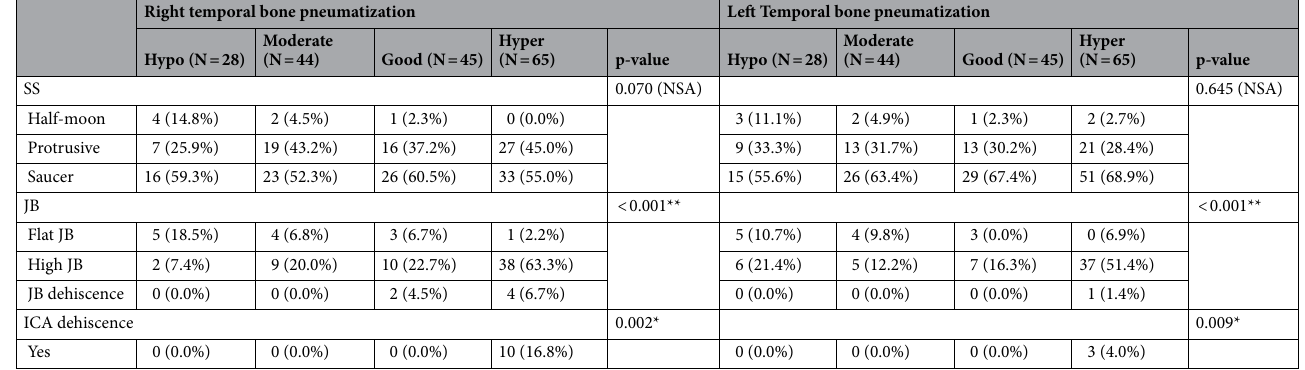
Table 6. Association between pneumatization of the temporal bone and some selected vascular variants of the sigmoid sinus, jugular bulb, and internal carotid artery. Fisher’s test showing significant association at *p < 0.01, **p < 0.001. NSA no significant association, SS sigmoid sinus, JB jugular bulb, ICA internal carotid